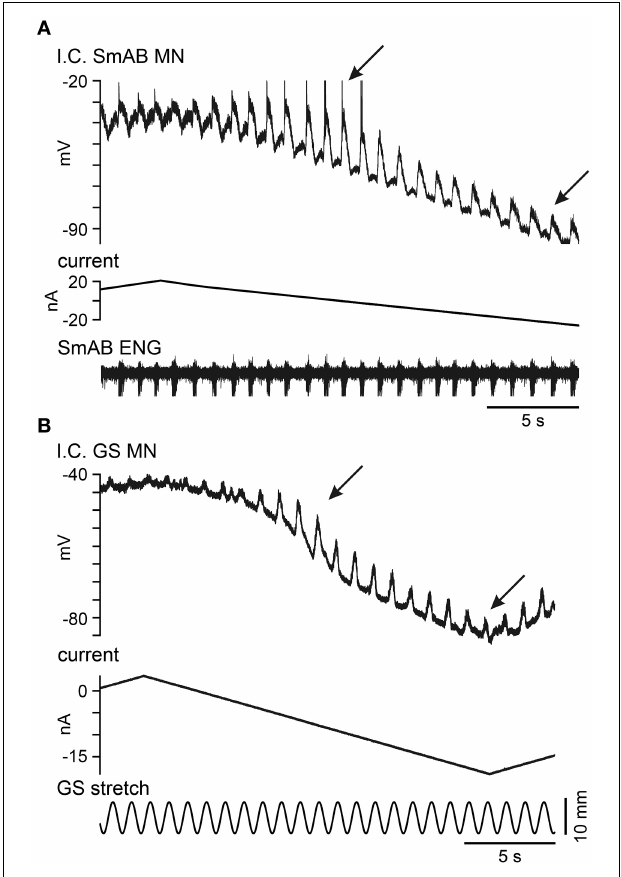
FIGURE 7 | Voltage dependent amplification of LDPs in a SmAB motoneuron and stretch-evoked Ia excitation in a GS motoneuron. (A) Recording from a SmAB motoneuron during spontaneous locomotor-like activity. The traces show the LDPs (top), the current injection (middle) and the SmAB ENG (bottom).The voltage dependent amplification of the LDPs (those between the arrowheads) are shown at the descending phase of a triangular current pulse. (B) Recordings from a GS motoneuron. The traces show the stretch-evoked EPSPs (top), the current injection (middle) and the sinusoidal muscle stretch of triceps surae (bottom). The arrowheads indicate the region where the amplification was present. At more depolarized levels the amplitude of the EPSP was smaller because of shunting (increased conductance), while the amplitude decreased at more hyperpolarized levels due to the voltage dependent amplification of the